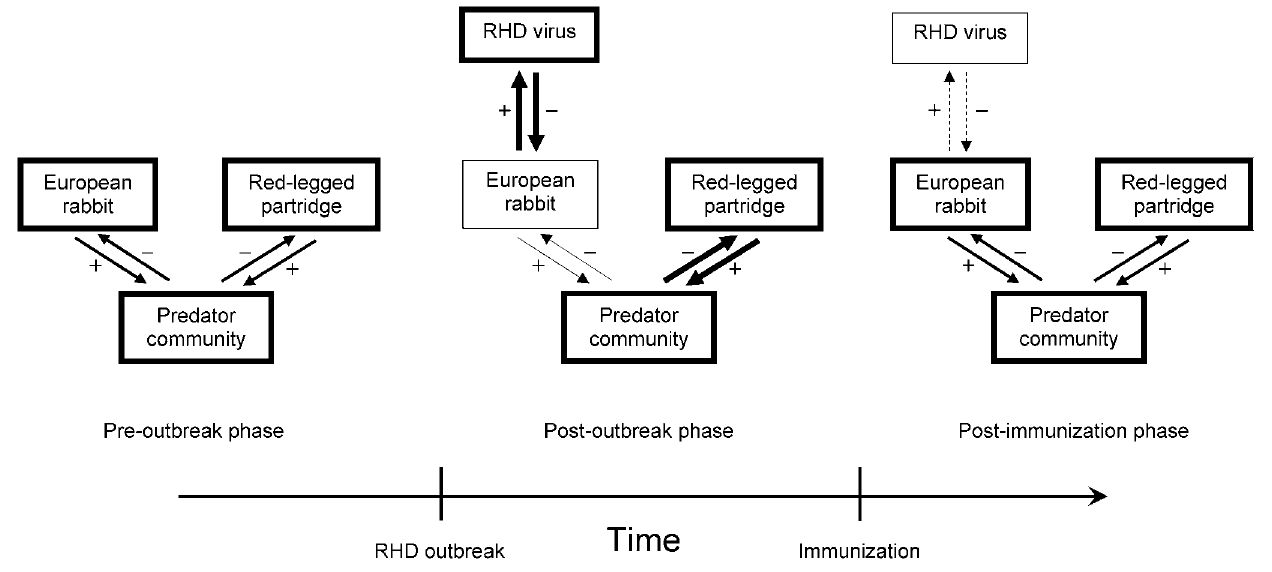
Figure 3. Graphical model depicting the ‘EID-mediated hyperpredation hypothesis’ . The thickness of each arrow denotes the numerical intensity of the interaction, while the thickness of each box represents the relative contribution of each species/community to the intensity of the multi-species interaction. Before the outbreak of the Rabbit Hemorrhagic Disease (RHD), the predators community fed differentially upon both prey species according to ‘‘average’’ traits (individual preferences, life-history, etc.) and environmental factors (local prey availability, etc.). At the onset of the RHD outbreak, the abundance of the host species, which is the main prey, drops abruptly, so the intensity of predation shifts towards the secondary prey. This causes its population abundance to decrease accordingly. Once the proportion of immunized hosts begins to increase, the intensity of the inter-specific interaction returns to the ‘‘average’’ (pre-outbreak) levels. The population sizes of both prey species begin to rise as well at this stage. However, a proportion of RHD viruses can prevail in the host